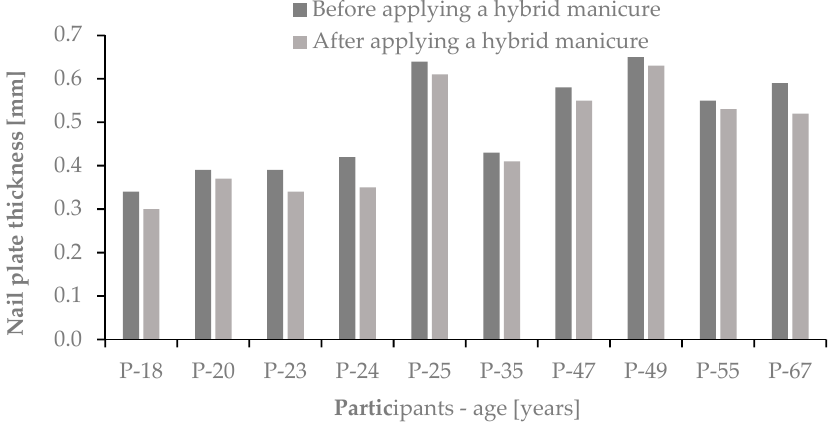
Figure 11. Changes in the thickness of the nail plate before and after applying a hybrid manicure.